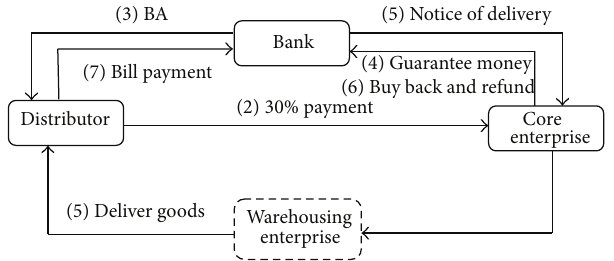
Figure 1: The process of buy back guarantee